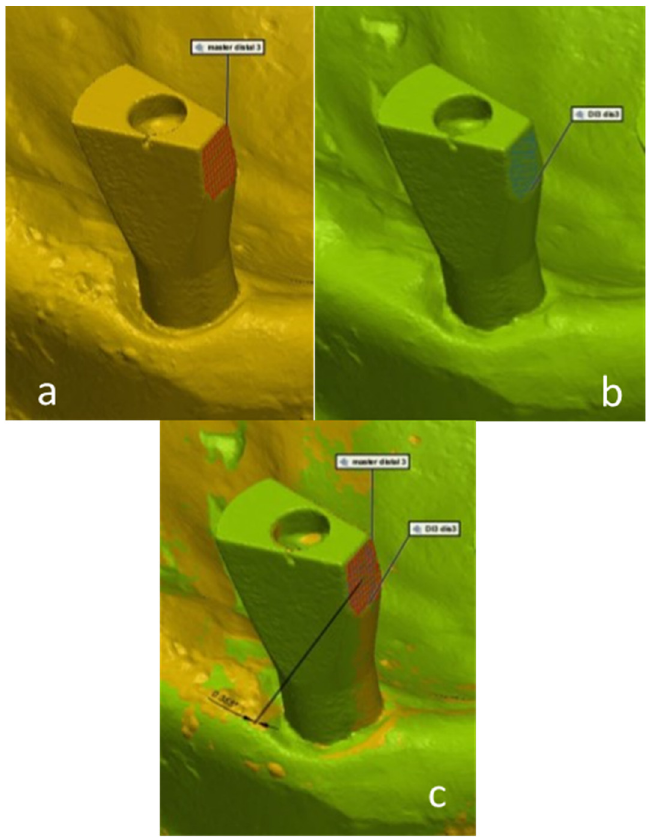
Figure 5. A digital 3D measurement of the angle between each matching scan abutment interproximal surface in the study model compared to the master model. a —master model scan; b —study group scan; c —master model scan digitally overlapped with study group scan .